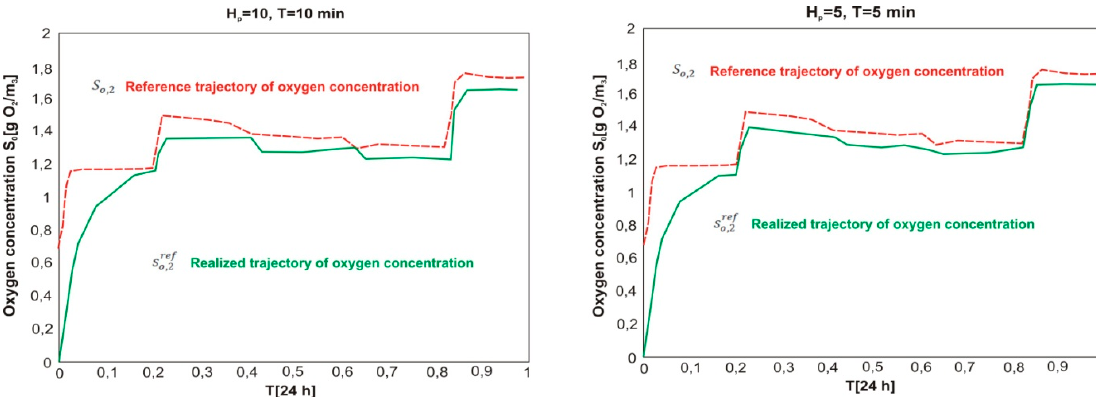
Figure 9. Trajectories of oxygen concentration (reference and realized) in the oxygen chamber 1 [own elaboration].